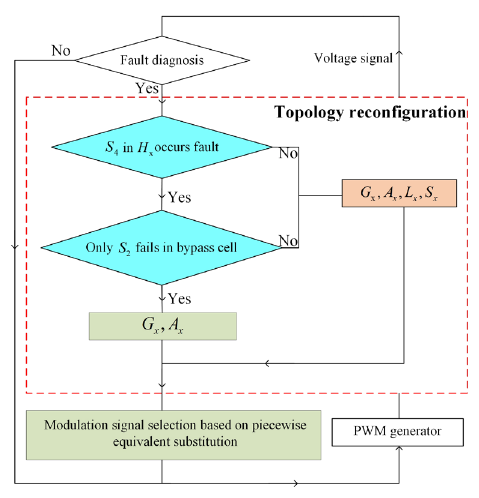
Figure 3. The flow chart of the SF-TC method.